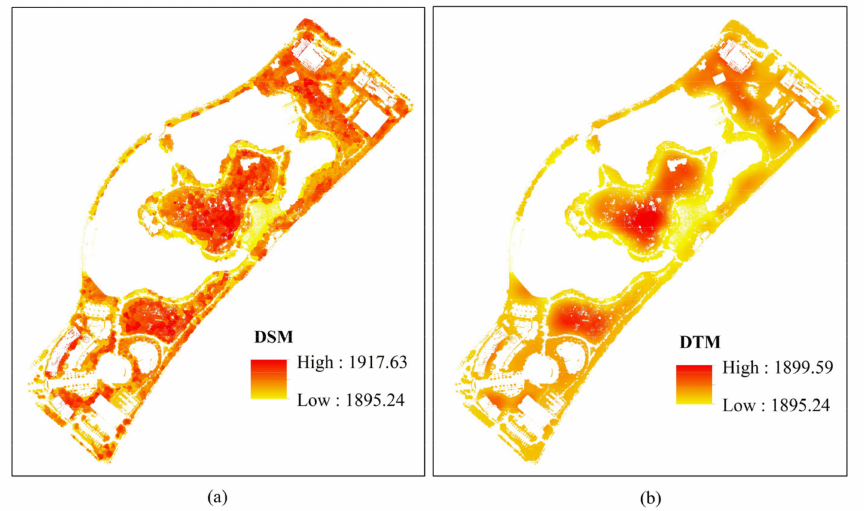
Figure 5. DSM and DTM of the vegetated area: ( a ) DSM of the vegetated area; ( b ) DTM of the vegetated